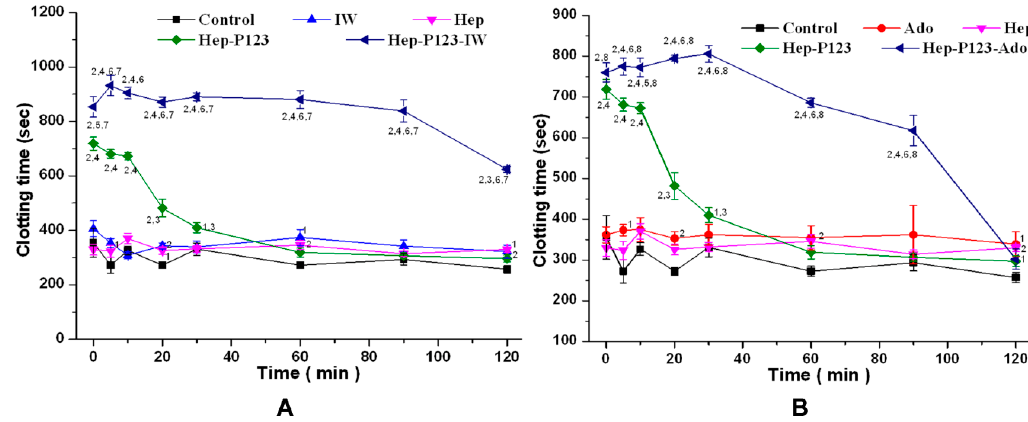
Figure 6. Whole blood coagulation time. Influence of the IW ( A ) and Ado ( B ) as well as their encapsulated forms on the clotting time in comparison with Hep and Hep-P123. The abscissa indicates the time after injection. M ± m. n = 9 for each group. The numbers near the points indicate the probability values ( p ). 1 − p < 0.05 and 2 − p < 0.01 compared with control. 3 − p < 0.05 and 4 − p < 0.01 compared with Hep. 5 − p < 0.05 and 6 − p < 0.01 compared with Hep-P123. 7 − p < 0.01 compared with IW. 8 − p < 0.01 compared with Ado.